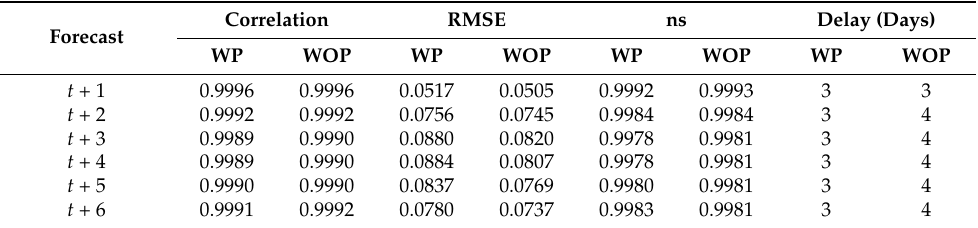
Symbology. WP = models with precipitation, WOP = models without precipitation, RMSE = root mean square error, NS = Nash–Sutcliffe efficiency.